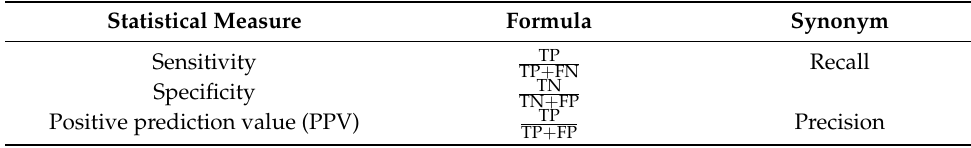
Table 7. Common statistical measures used in FF estimation. Statistical Measure Formula Synonym Sensitivity